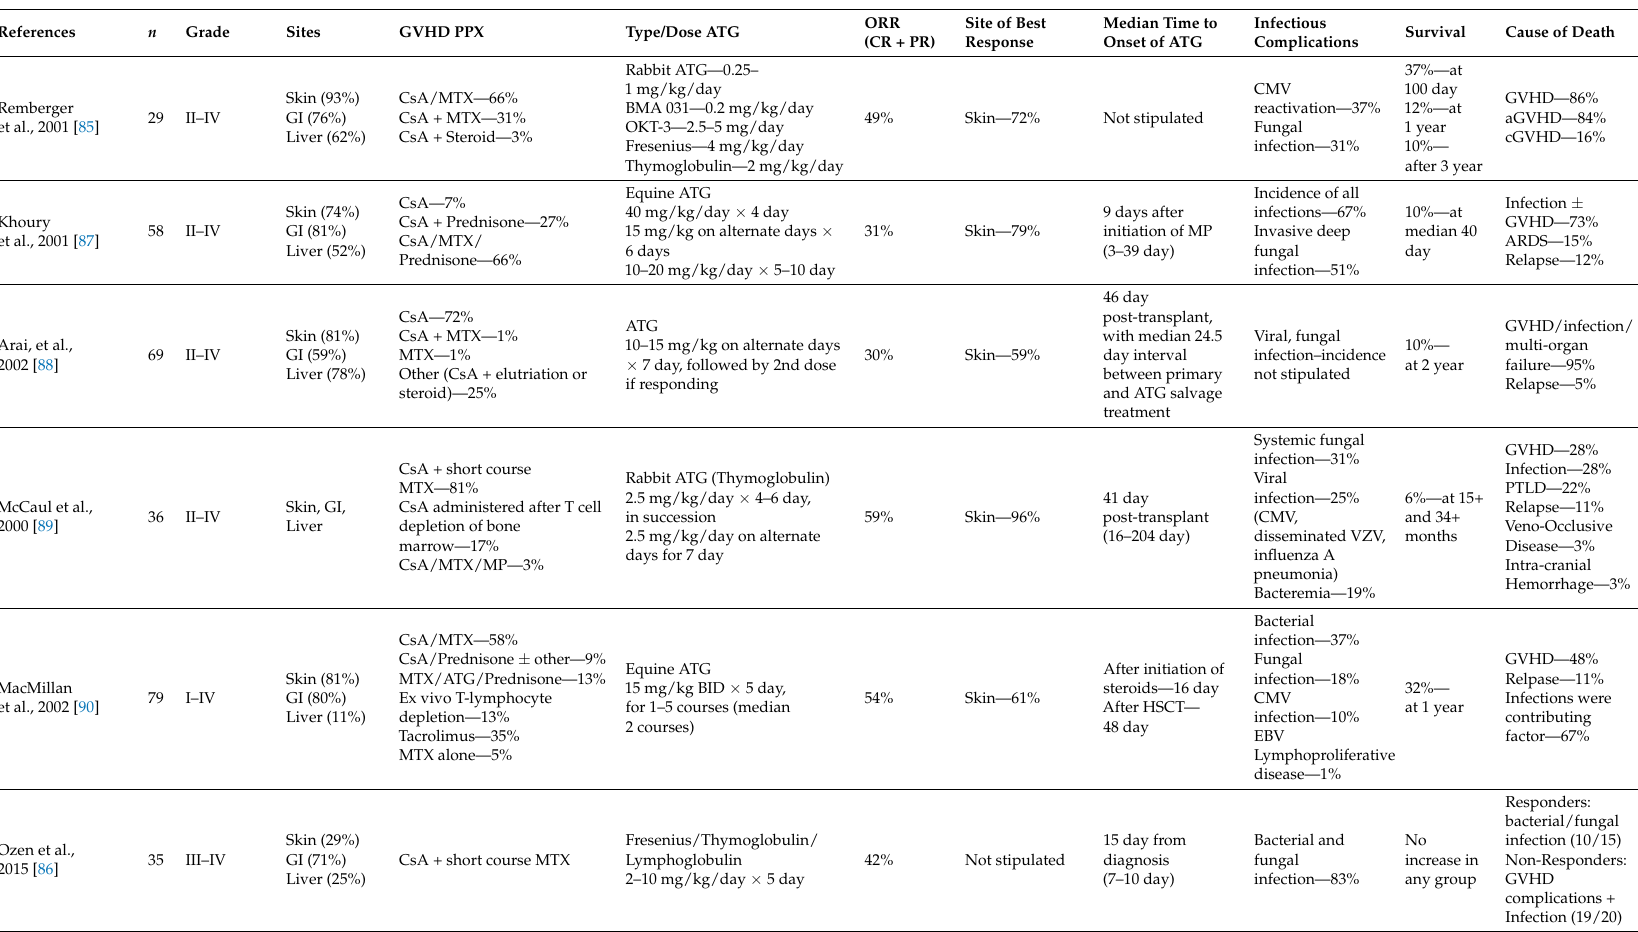
GVHD: Graft-versus-host disease; PPX: Prophylaxis; ORR: Overall response rate: CR: Complete response; PR: Partial response; CsA: Cyclosporine A; MTX: Methotrexate; PTLD: Post-transplant lymphoproliferative disease; MP: Methylprednisolone; CMV: Cytomegalovirus; EBV: Epstein-Barr